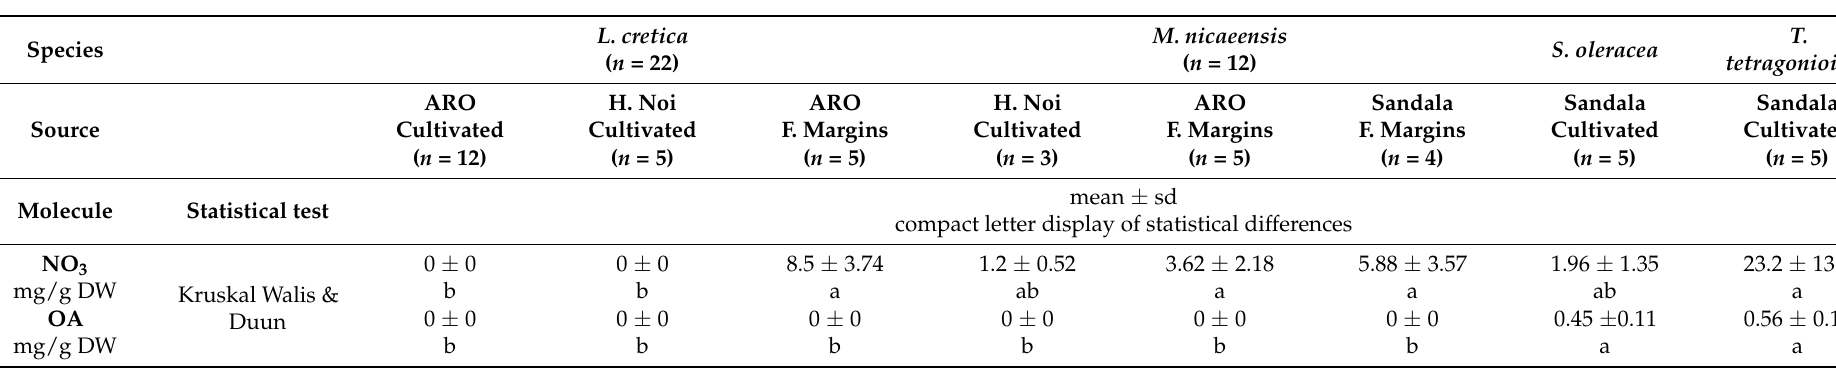
Table 2. Non-nutritive compounds in two Malvaceae species and two Spinach species. Value per each element is given in the first left column, and the statistical test performed in the second column to the left. Different lowercase letters indicate significant differences between populations of green leaves ( p < 0.05), comparing all populations per element. Number or samples for statistical replicates is given in parentheses ( n =